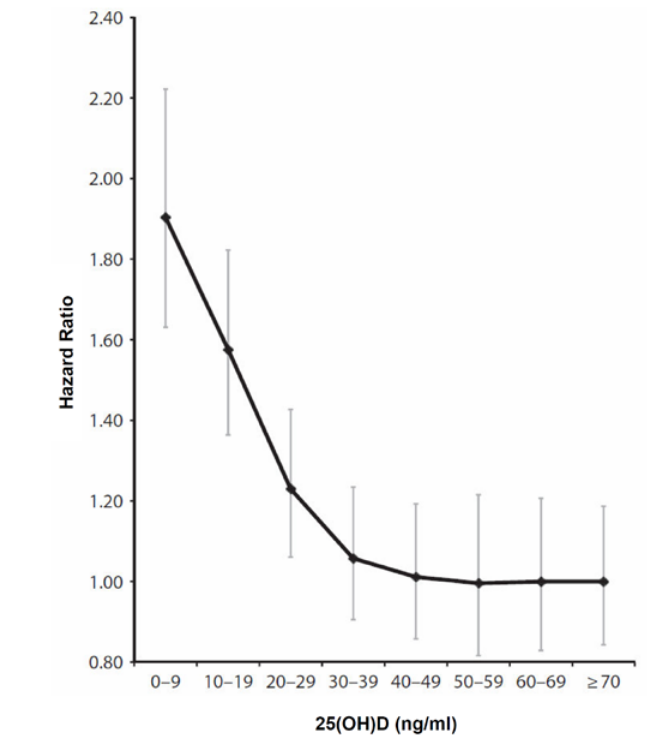
Figure 1. Age-adjusted hazard ratios for mortality of serum 25-hydroxyvitamin D in association with all-cause mortality (reproduced with permission)